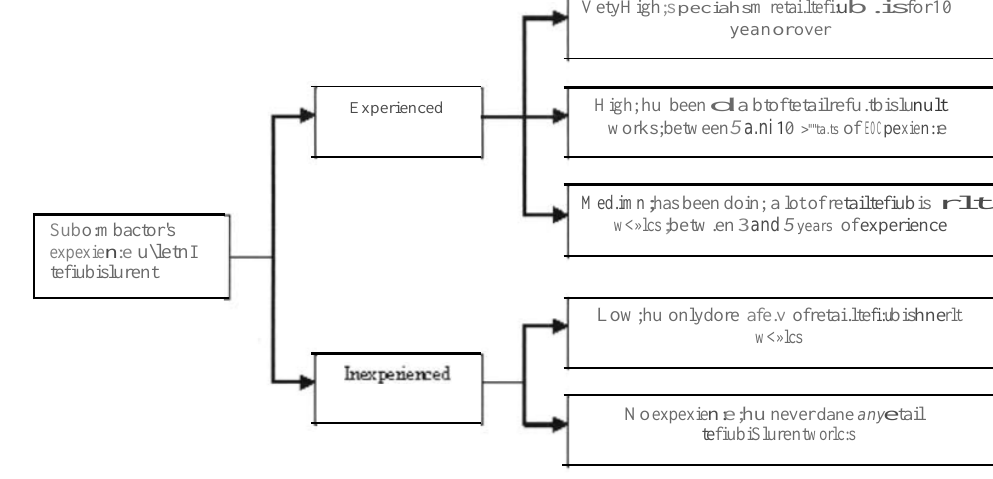
Figure 4: Taxonomy structure for reflecting the relationships of categorical